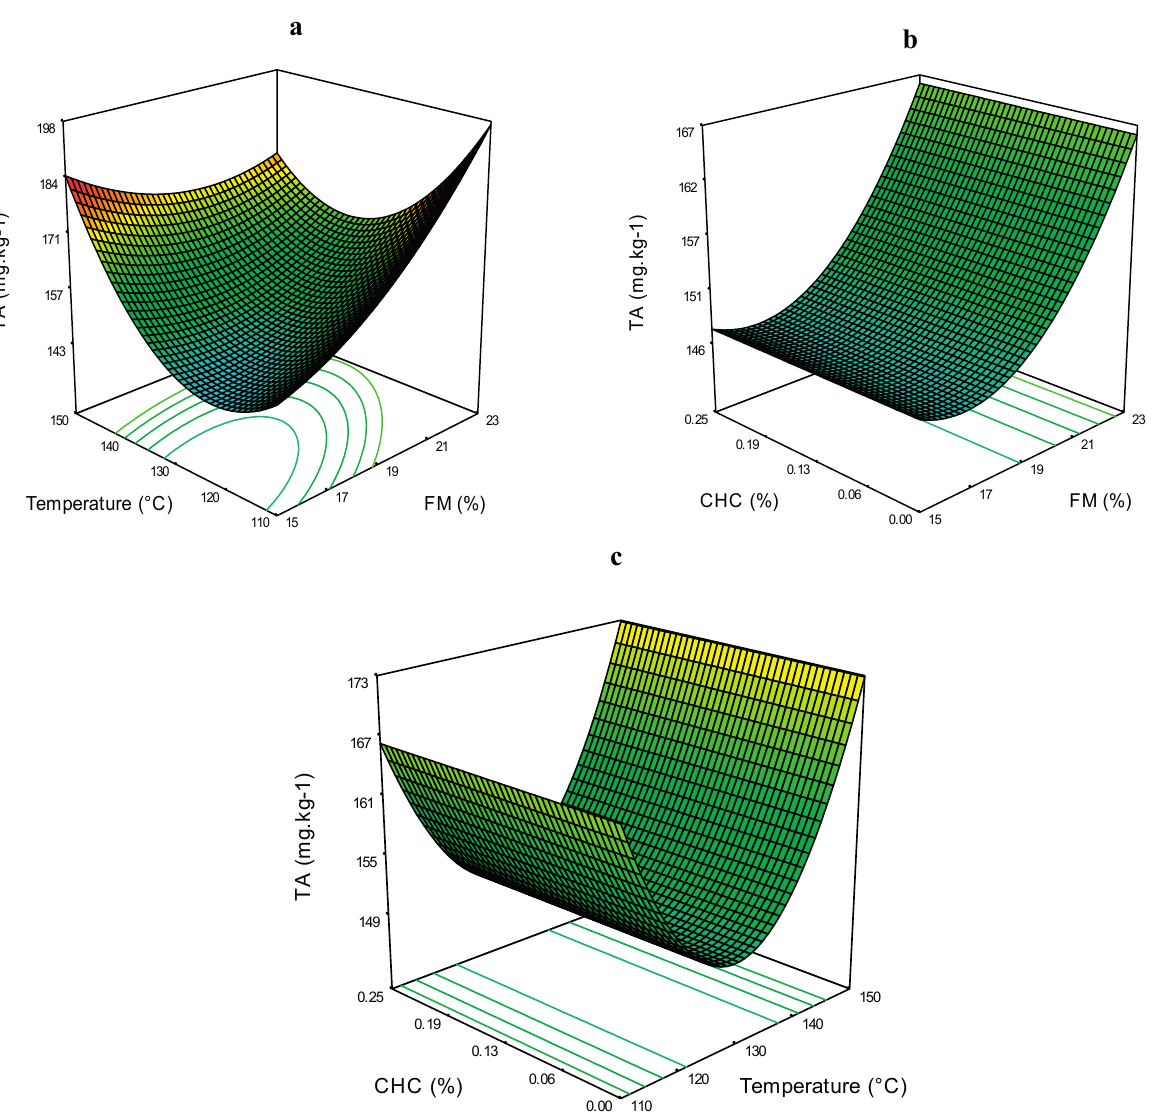
Figure 2 . Total anthocyanins (TA) of expanded nixtamalized blue corn extrudates, as a function of: ( a ) feed moisture (FM) and temperature (T); ( b ) feed moisture (FM) and calcium hydroxide concentration (CHC); and ( c ) temperature (T) and calcium hydroxide concentration